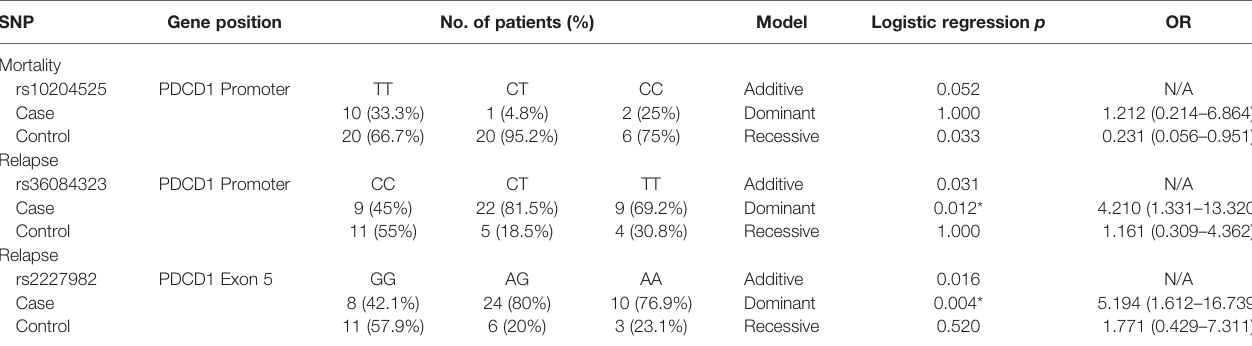
TABLE 6 | The SNPs in the PDCD1 gene associated with the outcomes of post-CBT. SNP Gene